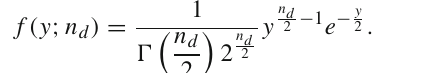
Fig. 1 Moments (cid:2) ξ the Borel parameter M 2 . The shaded bands stand for the corresponding Borel windows